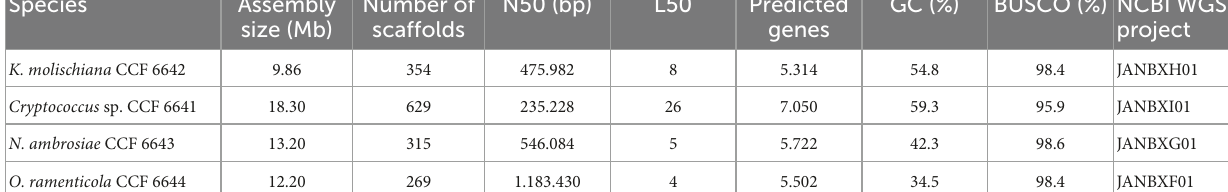
TABLE 2 Genome assembly statistics of yeasts isolated from the gut of Ips typographus. Species